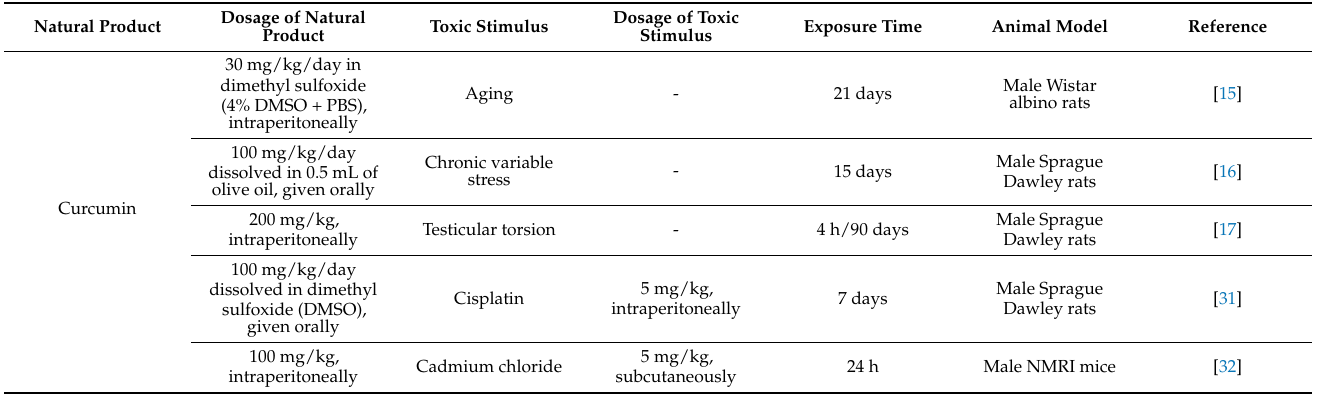
Table 1. Bioactive compounds with beneficial effects in male reproductive